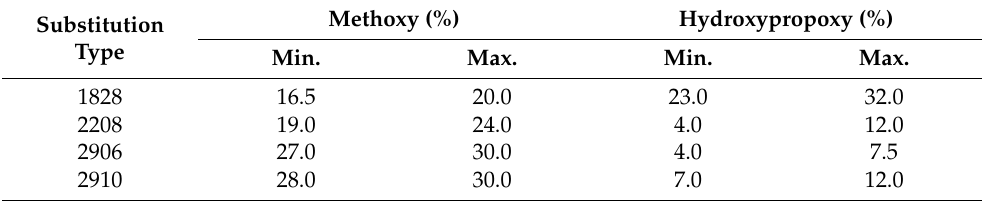
Table 2. Methoxy and hydroxypropoxy groups’ content in the various types of HPMC [13]. Substitution